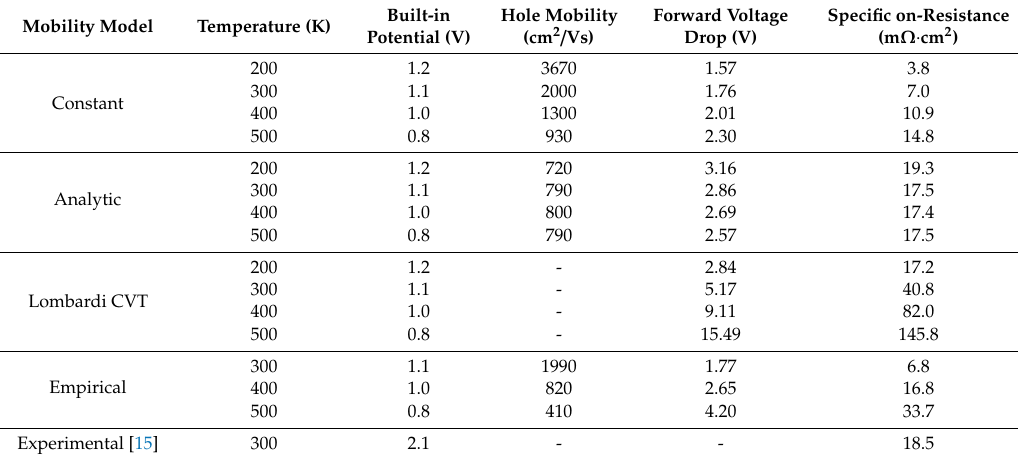
Table 2. Built-in potential, hole mobility, forward voltage drop ( V f ) and specific on-resistance ( R on,sp ) of the p-type diamond pseudo-vertical Schottky barrier diode (SBD) simulated using the constant, analytic, Lombardi CVT, and empirical mobility models. The constant mobility model used the µ const of 2000 cm 2 /